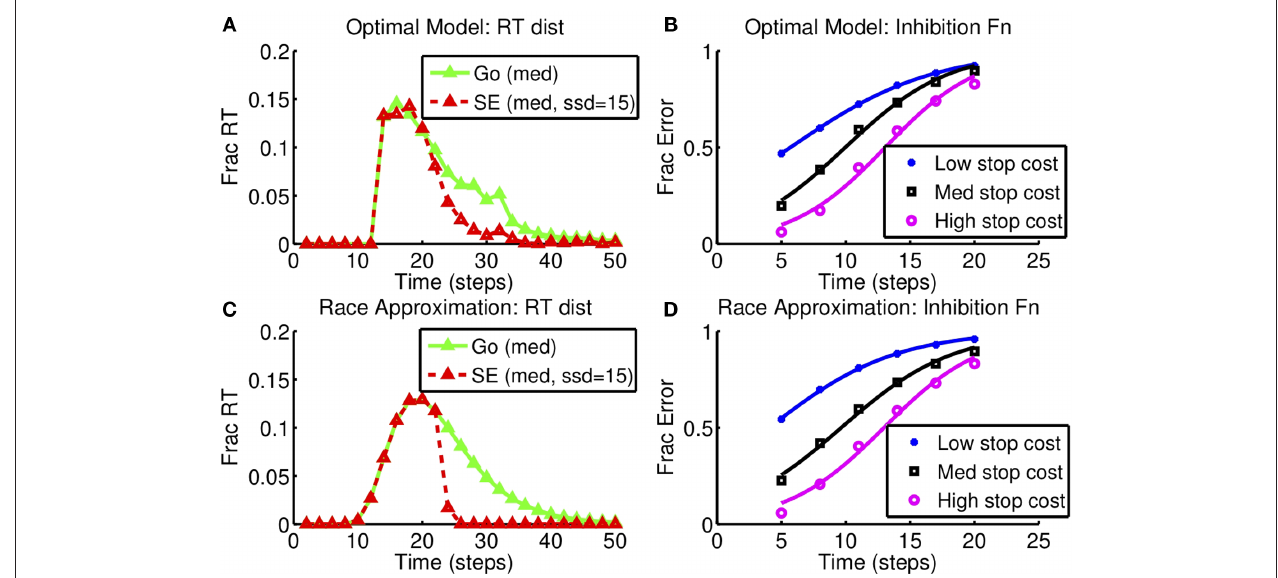
Figure 8 | race model approximation to optimal decision-making as stop error penalty is varied: inhibition function and rT distribution. (A,B) Optimal model. (C,D) Diffusion race model. Left: RT distributions for GO and SE trials. SSD = 15, c med: c = 0.25, high: c = 0.5). Results based on 10,000 simulated trials from the optimal model, and also from the corresponding best-fitting diffusion s s